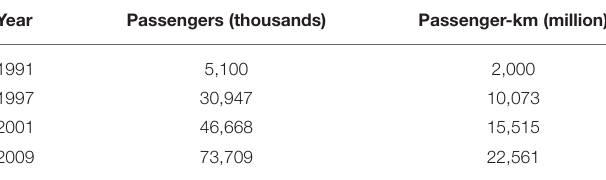
TABLE 3 | Germany’s High-Speed Rail Passenger